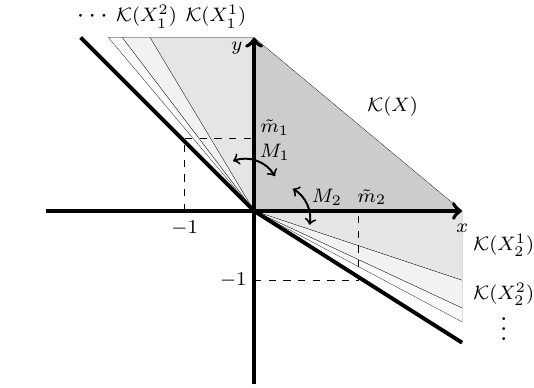
Figure 2 . An isomorphic flop between Kähler cones K ( X ) and K ( X 1 by M 1 (left) and an infinite flop chain, generated by M 1 and M 2